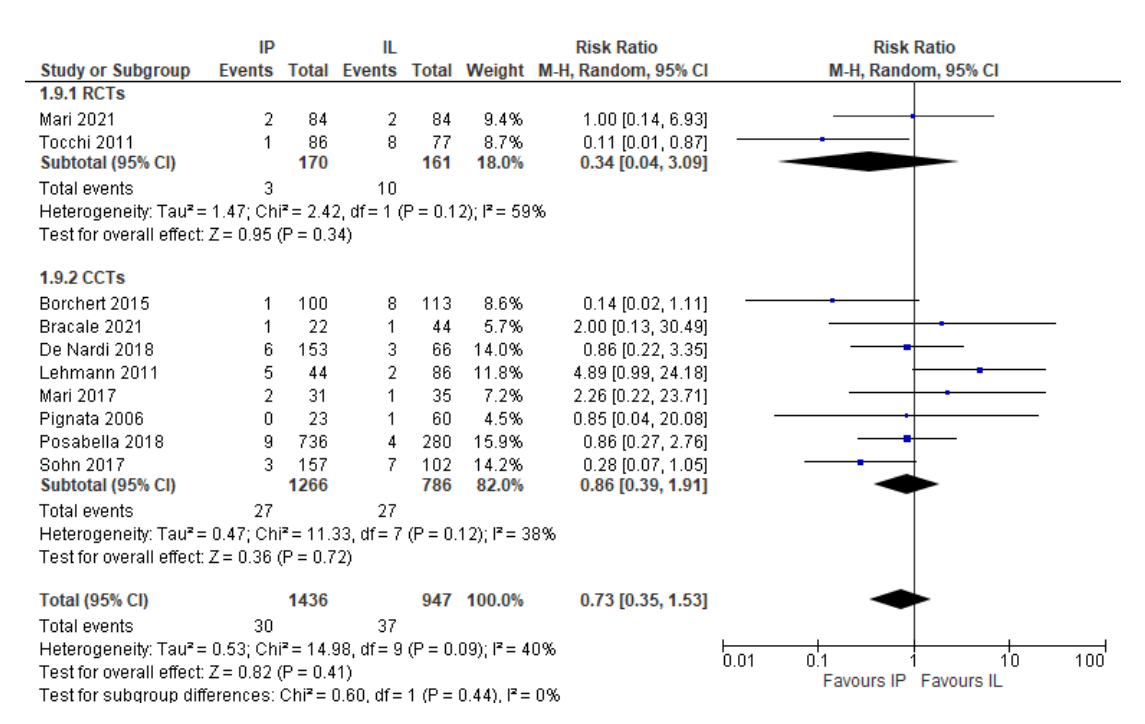
Figure 4. Anastomotic leak risk ratio.